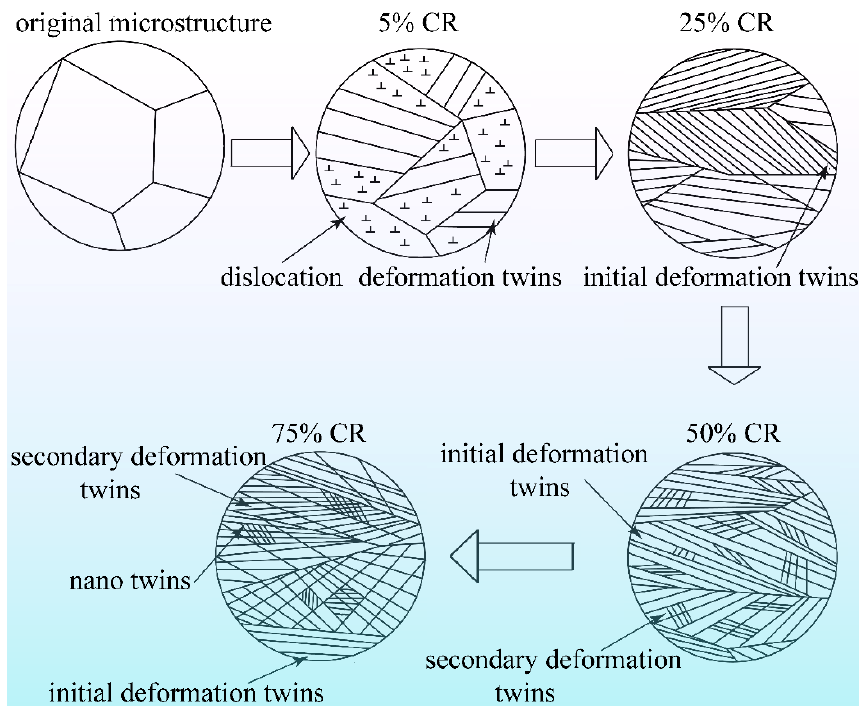
Figure 7. Illustration of the microstructural evolution in TWIP steel as CR deformation increases.